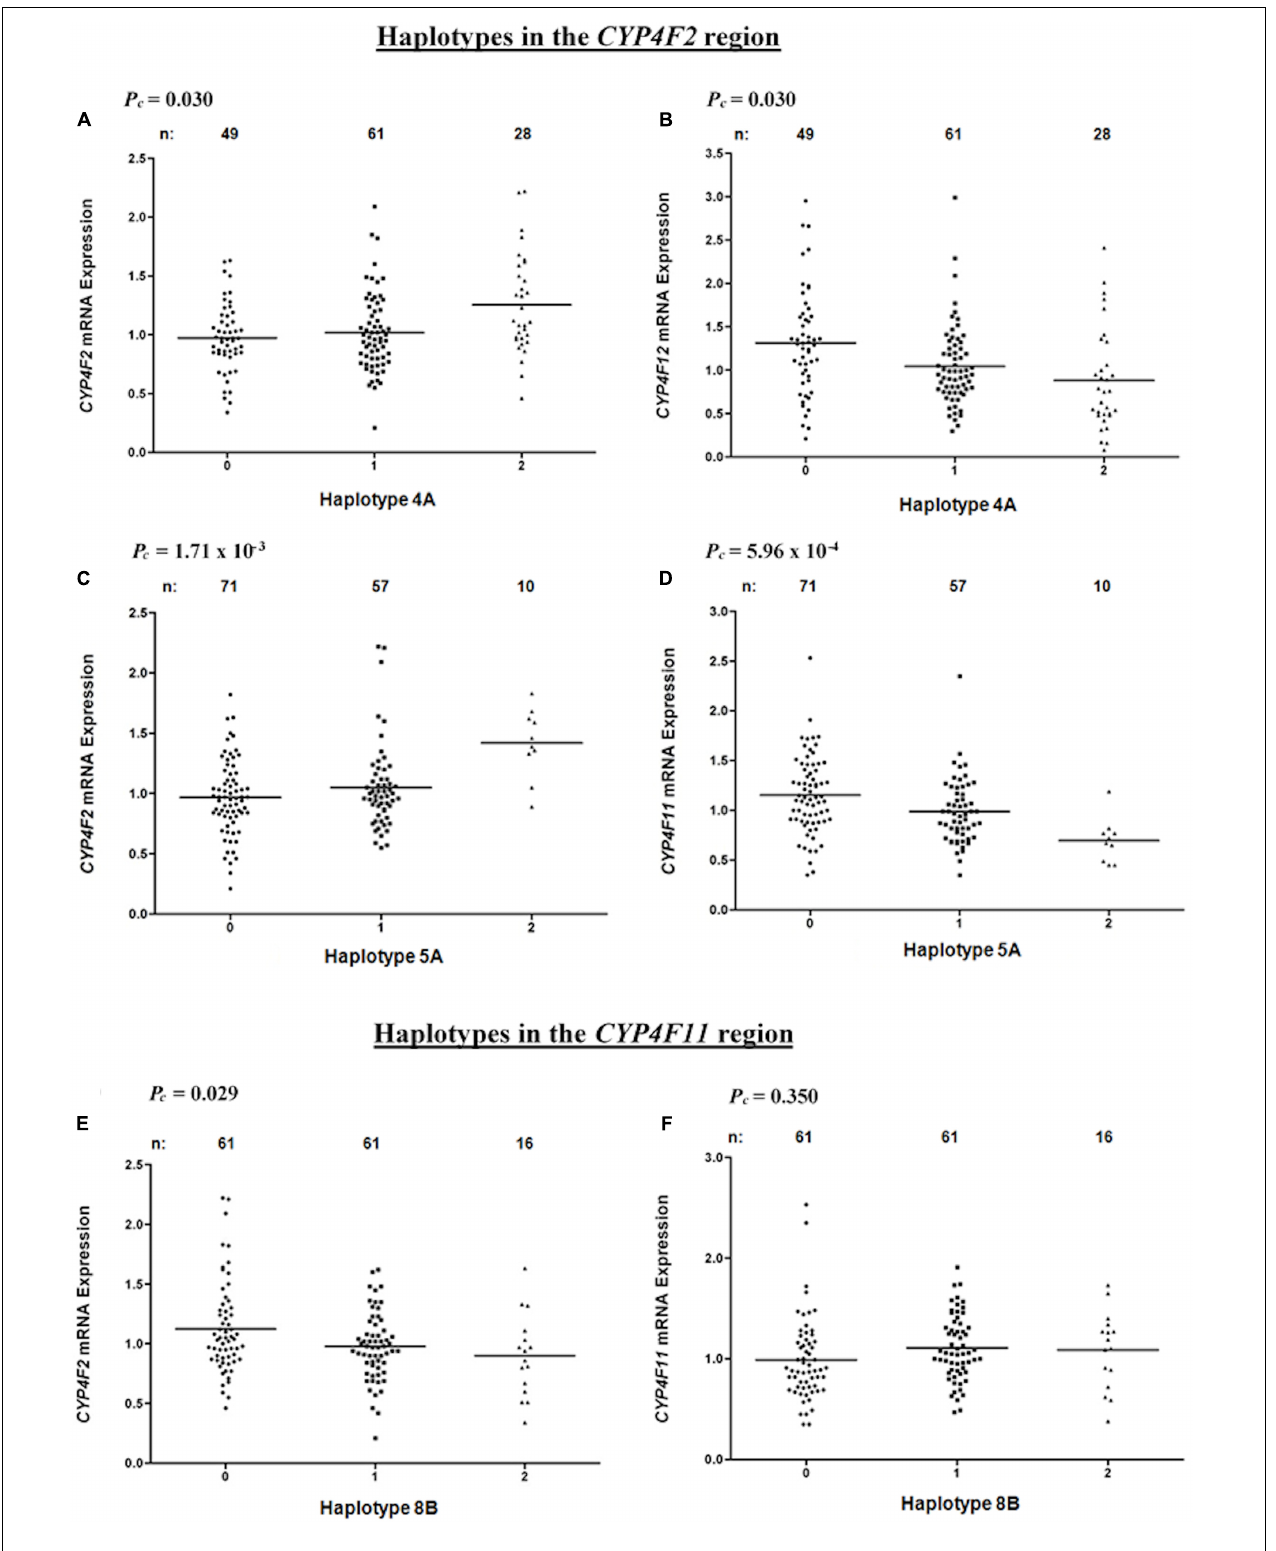
FIGURE 4 | Levels of hepatic CYP4F2 , CYP4F11 , CYP4F12 mRNA in normal liver tissue donated from 149 patients in relation to haplotypes across the CYP4F2 - CYP4F11 locus. (A,B) Haplotype 4A harboring sequence ‘AT’; (C,D) Haplotype 5A harboring sequence ‘TGCGGTGGG’; (E,F) Haplotype 8B harboring sequence ‘TGC.’ FDR -corrected P -values ( P c ) are shown in the upper left corner. Each dot represents an individual and the solid lines represent the mean values.